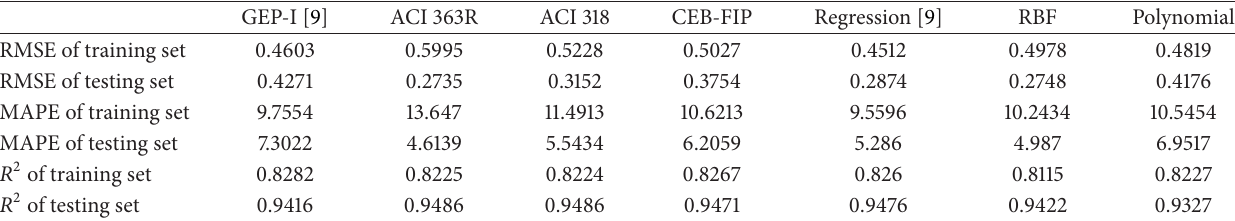
from 150 × 300mm cylinder 𝑓 𝑐 spt